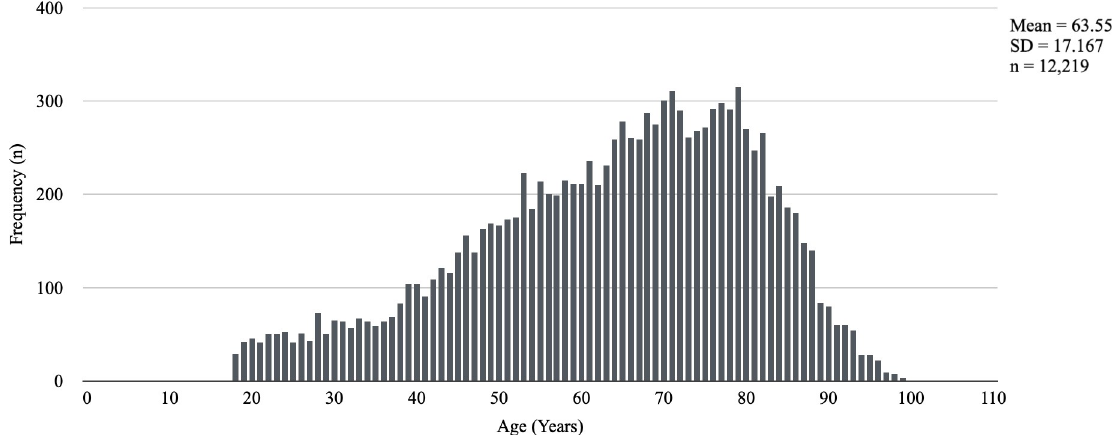
Fig 1. Age distribution in the hospitalized sample.